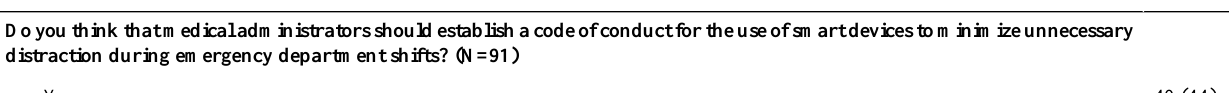
n (%)The need for a code of